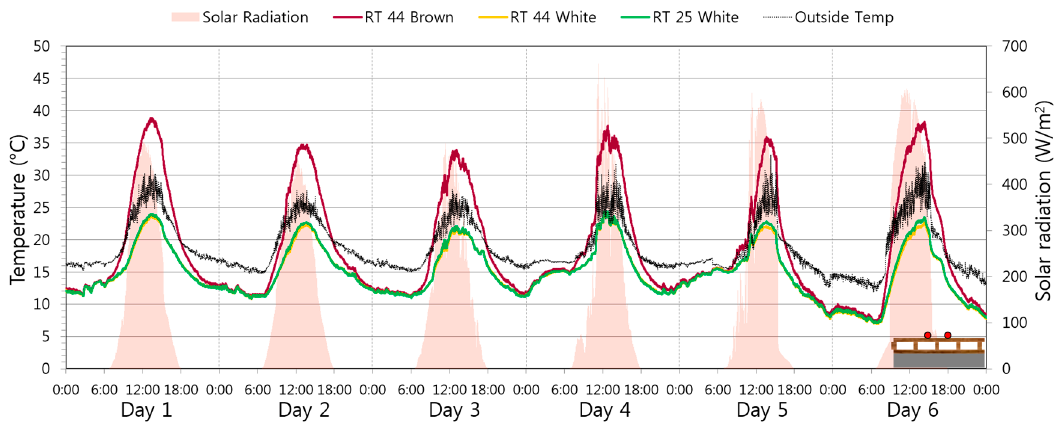
Figure 11. Variation in outer surface temperature with finishing color and PCM.